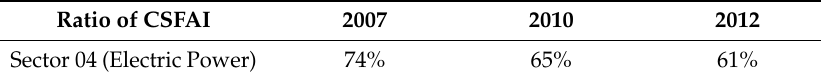
Table 4. The pcsfai of Sector 04 (Electric Power).